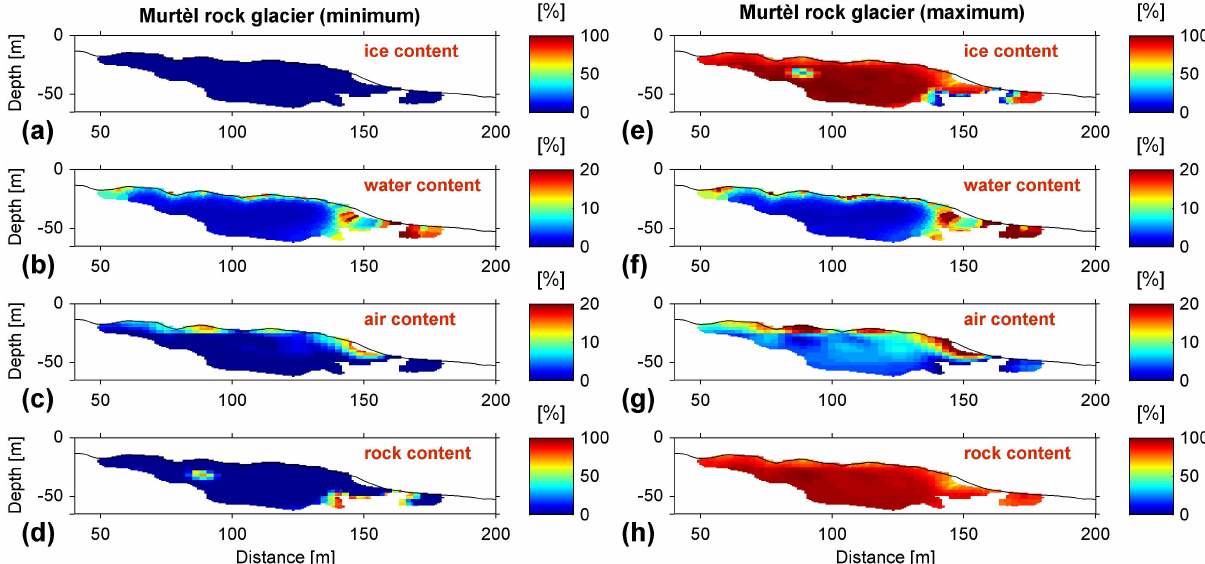
Fig. 13. General 4-phase model results for Murt`el rock glacier. (Left) Minimum values and (right) maximum values. Note, that the range of the colour scales is